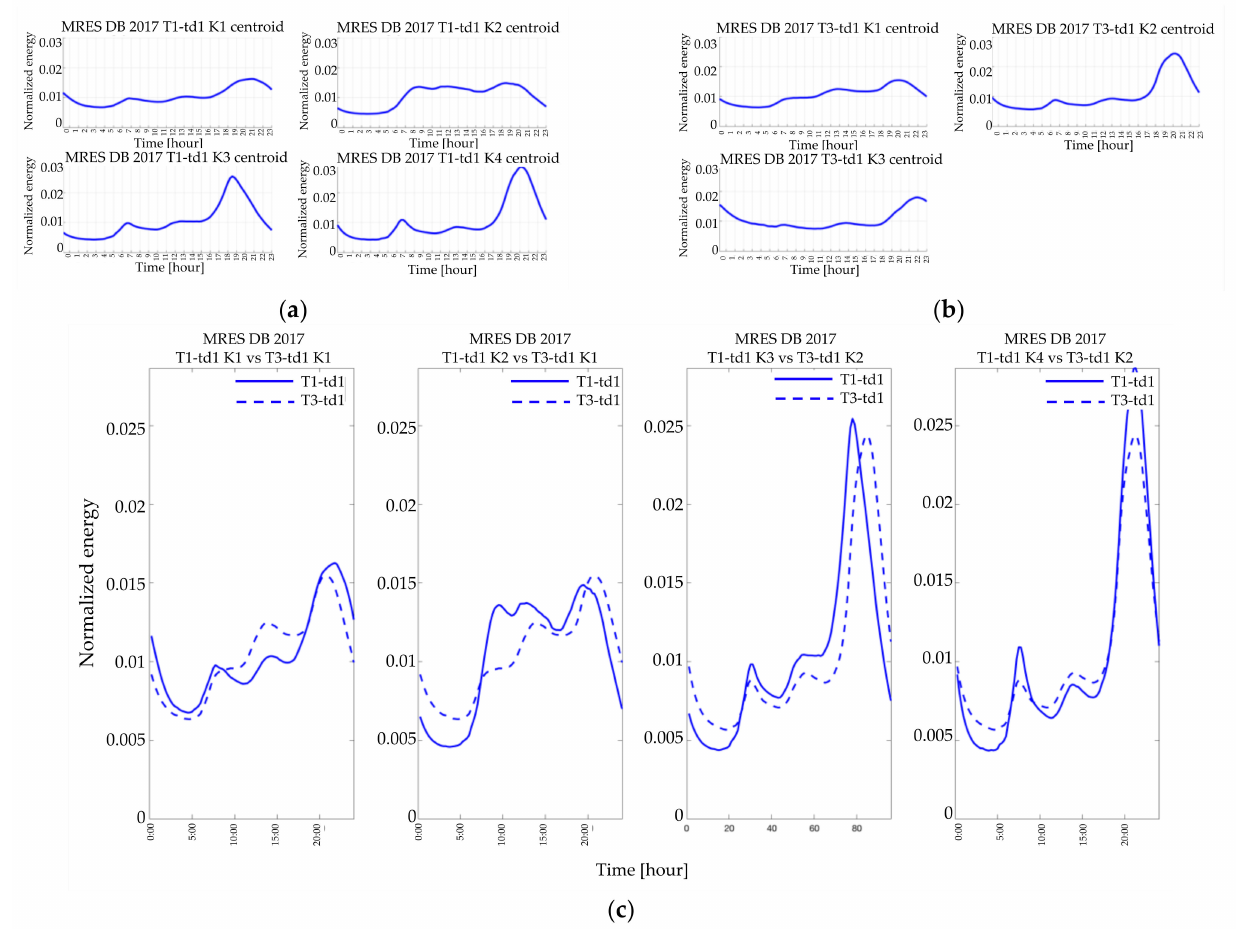
Figure 15. Database 2017, main residence contract (MRES) costumer, normalized centroids: ( a ) winter workdays (five clusters), ( b ) summer workdays (five clusters), ( c ) comparison between the two typical days.